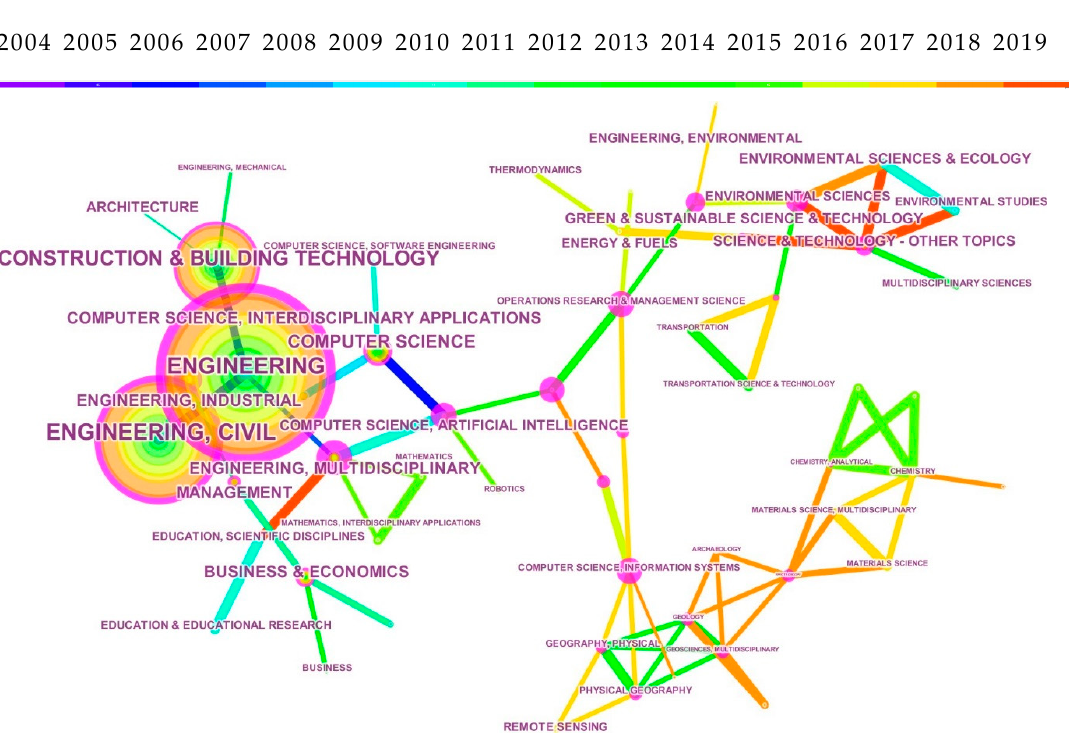
Figure 7. Network of co-occurring subject categories.